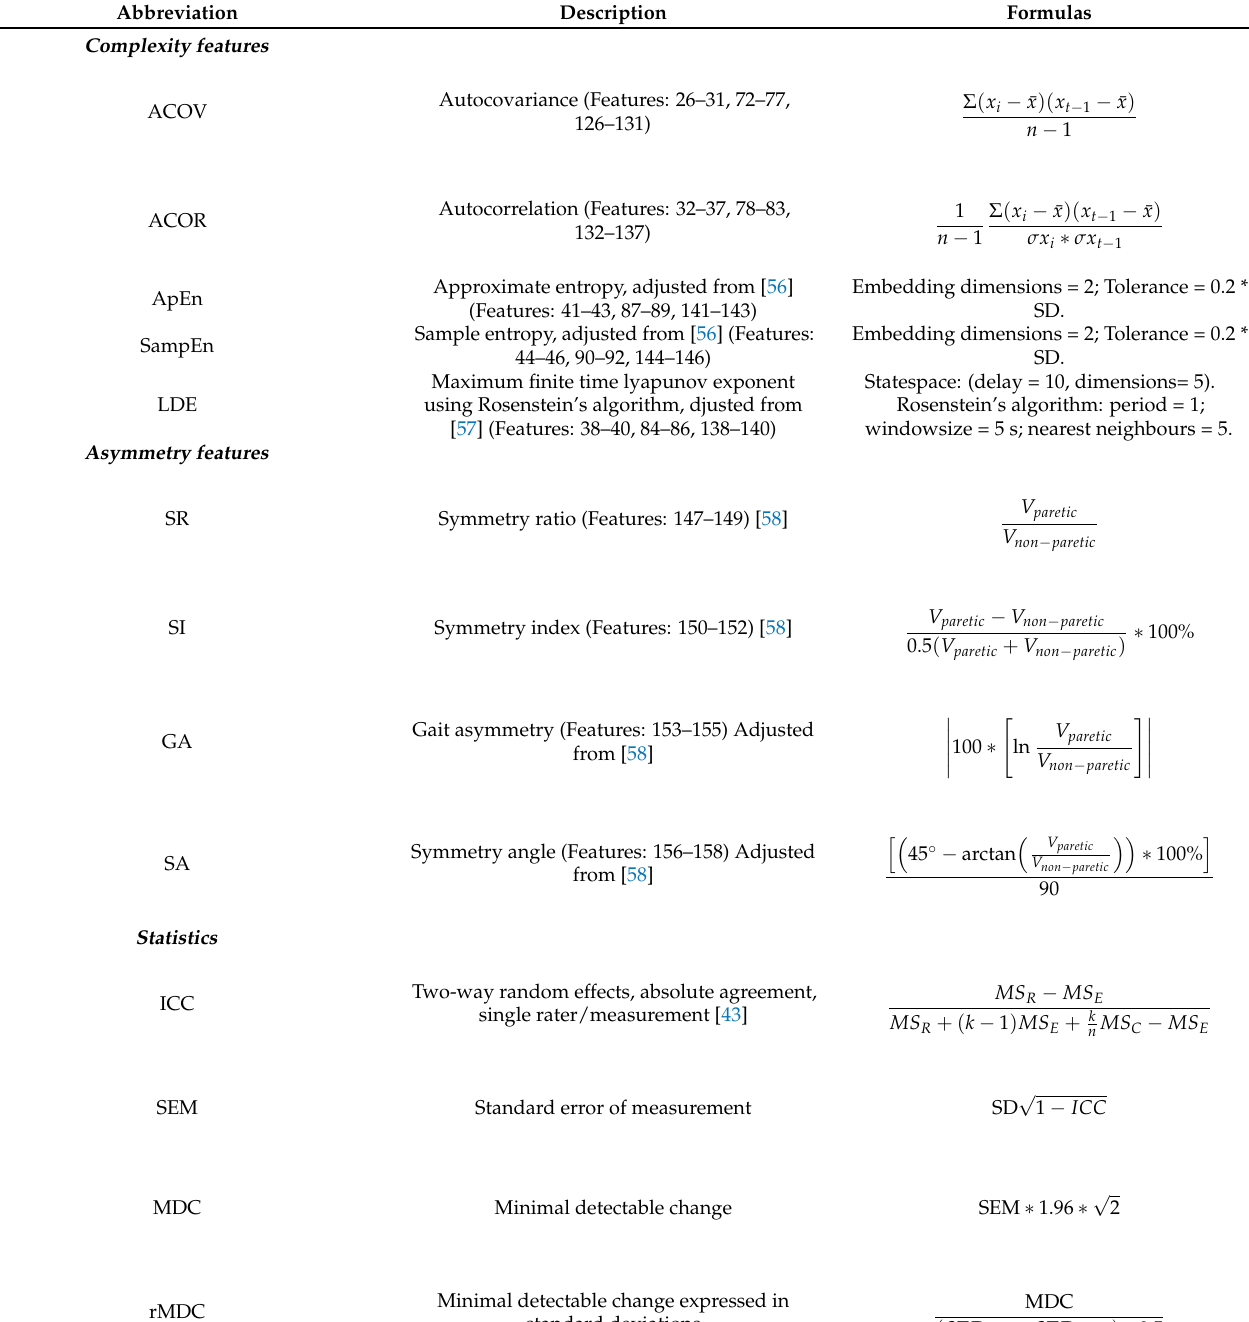
Table A4. Formulas: Complexity and Asymmetry Features and